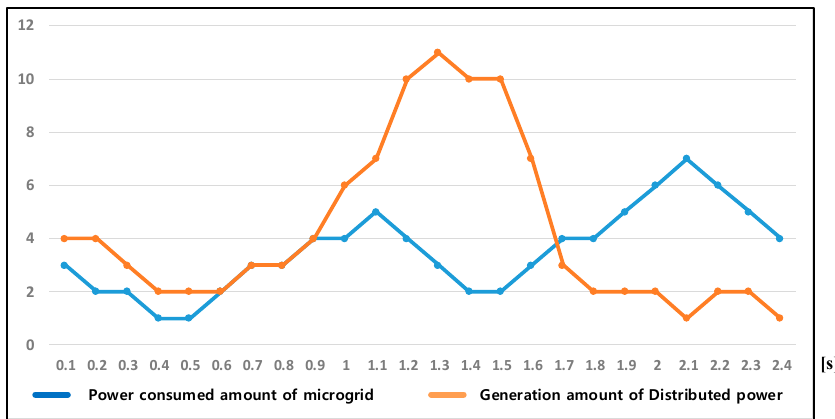
Figure 14. Load pattern and distributed power generation amount in reference to time applied to simulation.